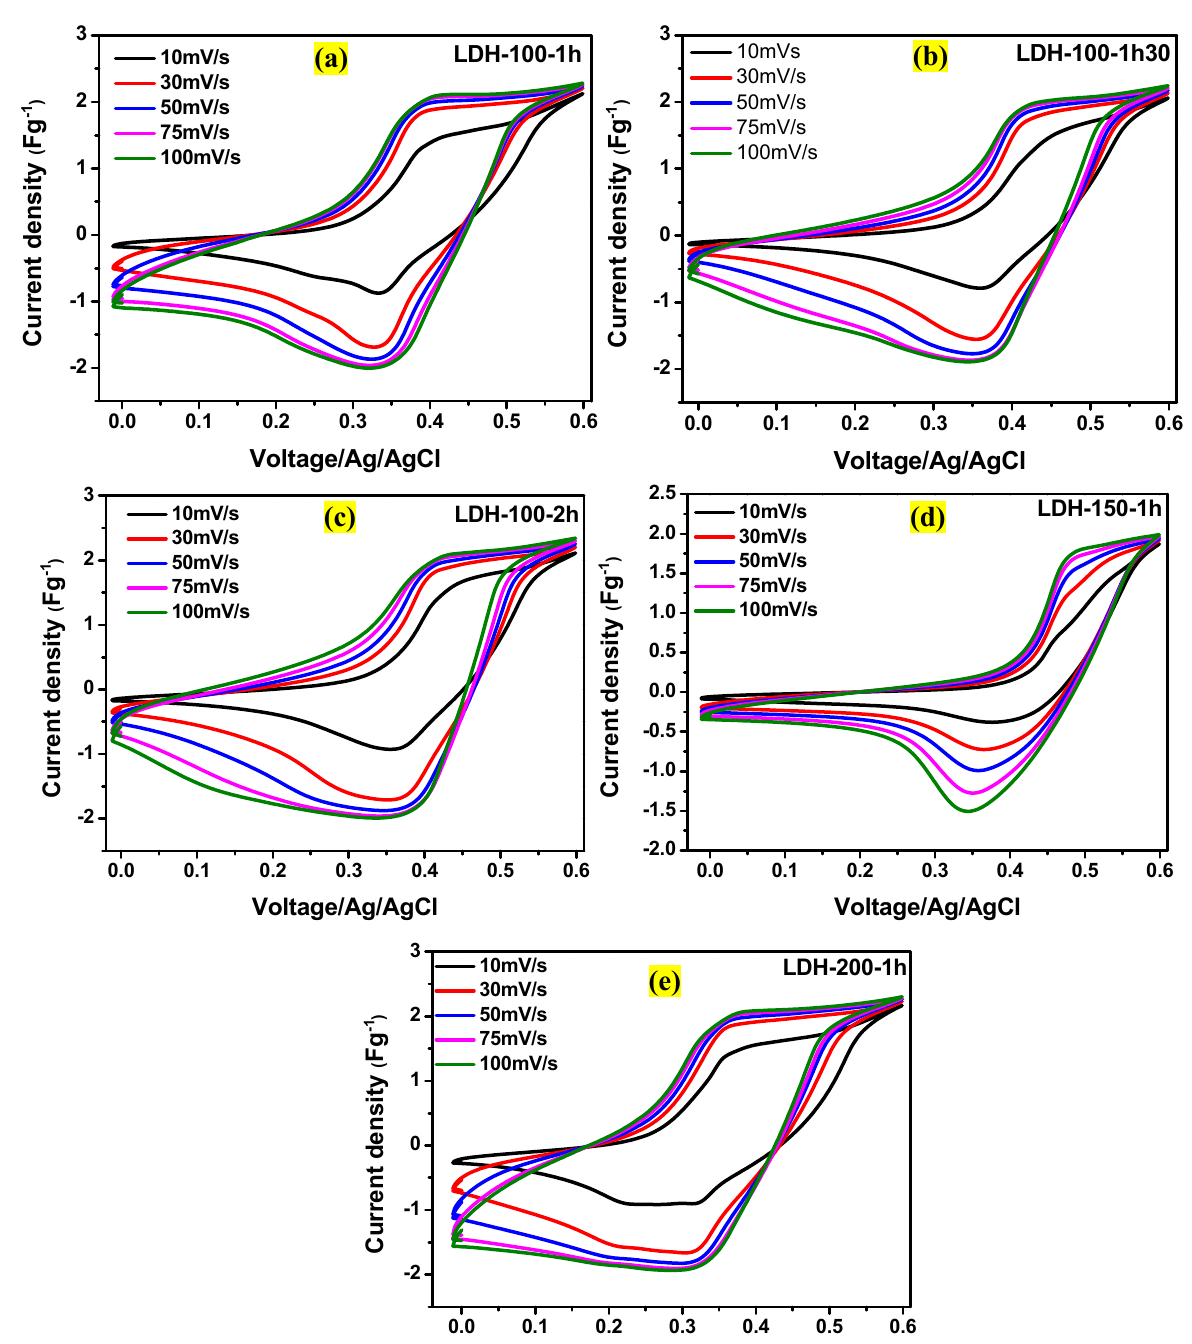
Figure 6. CV curves for the ( a ) LDH-100-1h, ( b ) LDH-100-1h30, ( c ) LDH-100-2h, ( d ) LDH-150-1h, and ( e ) LDH-200-1h electrodes, respectively at various scan rates. Consequently, Figure 7a–e display the dependence of anodic peak current (ipa) on the square root of the scan rate for all the electrodes revealing values of their R 2 which were considered as their b values. The results demonstrate that the reaction mechanisms for all the electrodes were governed by the surface capacitance and diffusion-controlled processes. Thereafter, Equations (4) and (5) [28] were used to estimate the contribution of each process in the overall kinetic mechanism for all the electrodes.